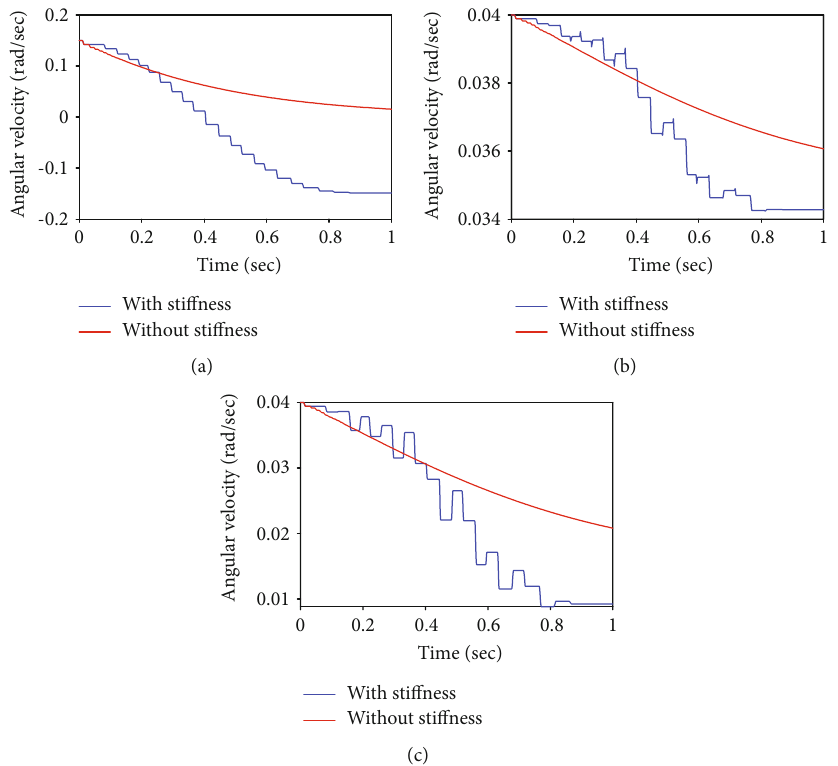
Figure 14: Angular velocity of the target satellite during identi fi cation: (a) X axis, (b) Y axis, and (c) Z axis.